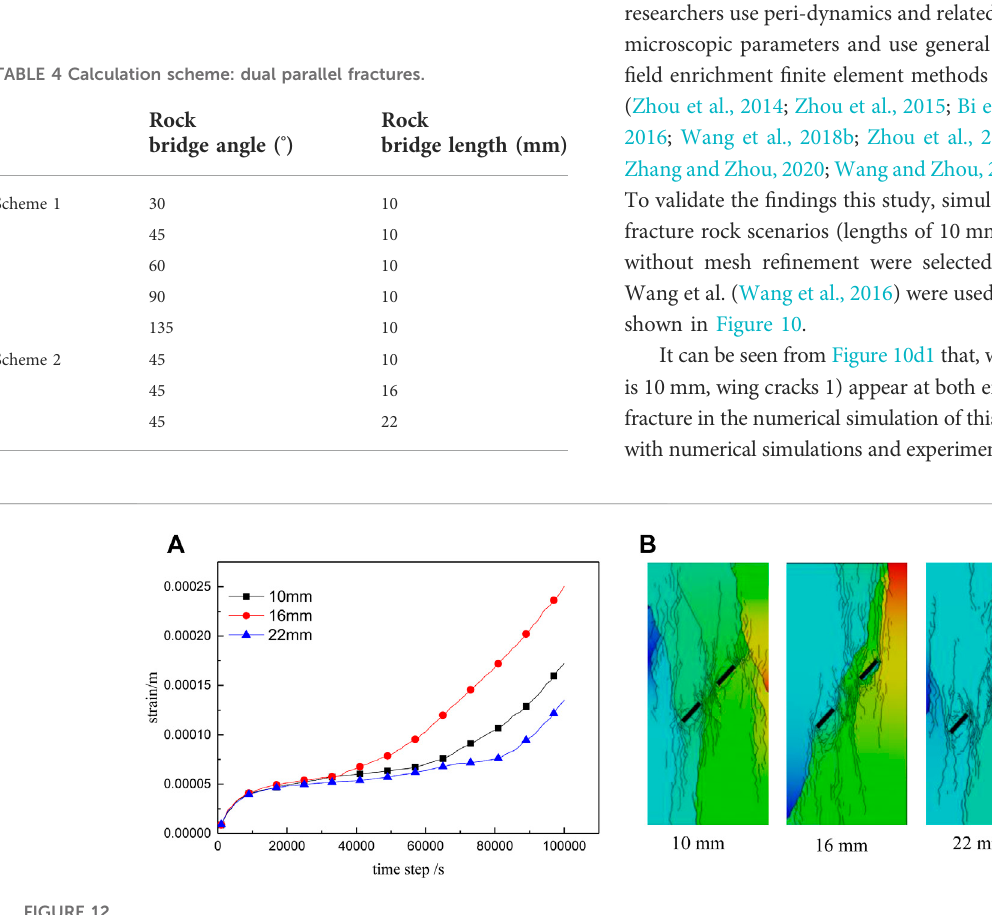
FIGURE 12 Creep curve (A) and rupture diagram (B) for fractured rock masses with different rock bridge lengths.